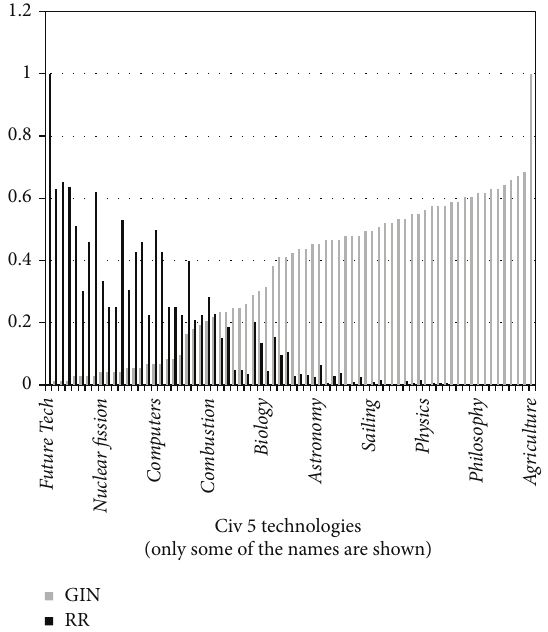
Figure 8: GIN (= GIN1 = GIN2) values and corresponding RR values of the technologies in the Civ 5 tech